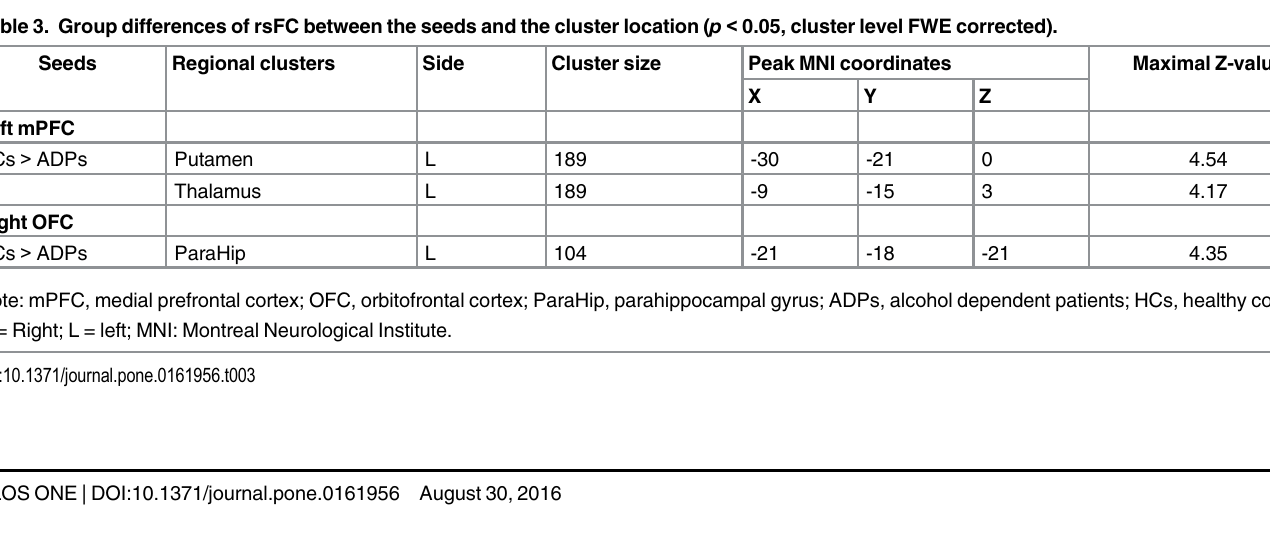
Table 3. Group differences of rsFC between the seeds and the cluster location ( p < 0.05, cluster level FWE corrected). Seeds Regional clusters Side Cluster size Peak MNI coordinates X Y Z